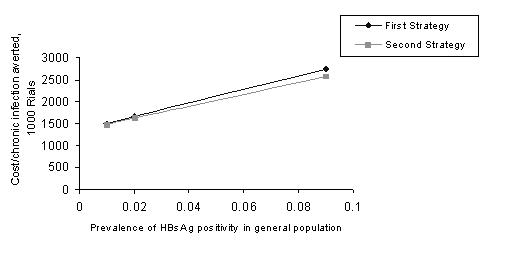
While the prevalence of HBsAg positivity in general population (P1) varied from the minimum to maximum in sensitivity analysis, the cost per HBV chronic infection averted varied from 1,503,440 Rials (183 $) to 2,740,560 Rials (330 $) in strategy 1 and from 1,482,620 Rials (179 $) to 2,568,310 Rials (309 $) in strategy 2; strategy 2 remained slightly cheaper throughout the range.